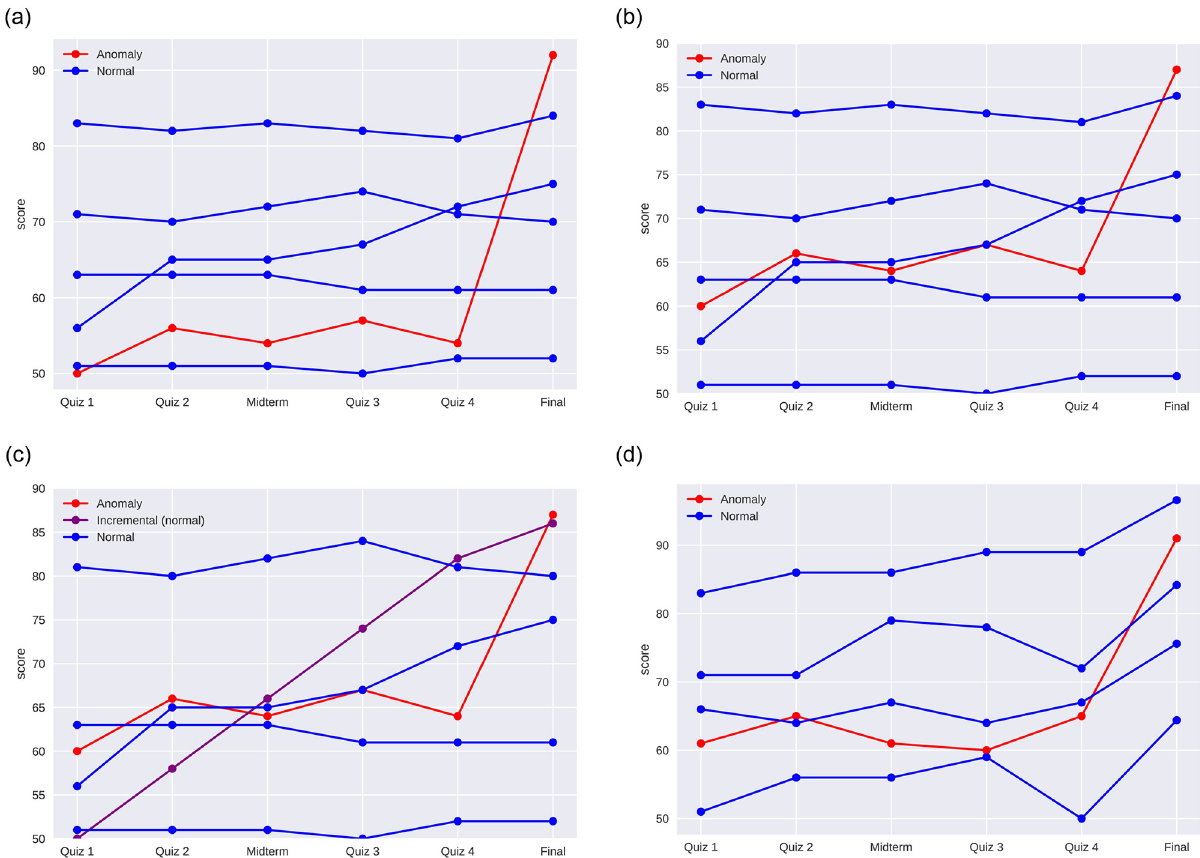
Fig 3. Representative samples of the simulated datasets used in our experiments. The datasets capture different scenarios for the distribution of the grades. (a) A representative sample of Dataset 1 grades. The dataset consists of 91% normal and 9% anomalous grades. The normal grades consist of three quarters homogeneous grades and one quarter increasing grades. The anomalous grades rise sharply —by 35 points—during the final exam. (b) A representative sample of Dataset 2 grades. The dataset is similar to Dataset 1. However, the anomalous grades rise less sharply —by 20 points—during the final exam. As a result, the outliers are harder to identify. (c) A representative sample of Dataset 3 grades. The dataset is similar to Dataset 2. However, around 10% of the normal grades are increasing at an incremental pace so that the difference between the average prior and final exam scores are same as in the anomalous instances. As a result, it is even more challenging to identify the outlier scores. (d) A representative sample of Dataset 4 grades. The dataset is designed to simulate a scenario when the final exam is easy and everyone receives a relatively high grade. The normal final exam scores 10 points higher than the average on prior assessments. The anomalous final exam scores 25 points higher than the average preceding scores.